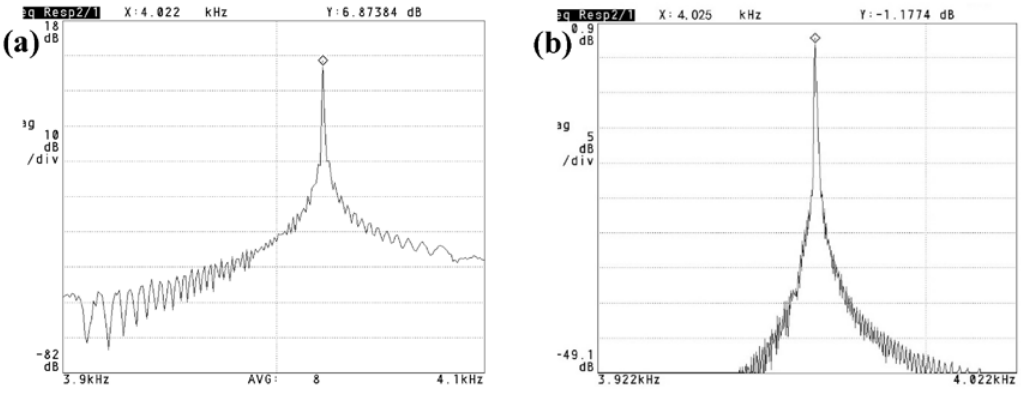
Figure 12. Resonant frequency and quality factor measurement. ( a ) Drive mode; ( b ) Sense mode.